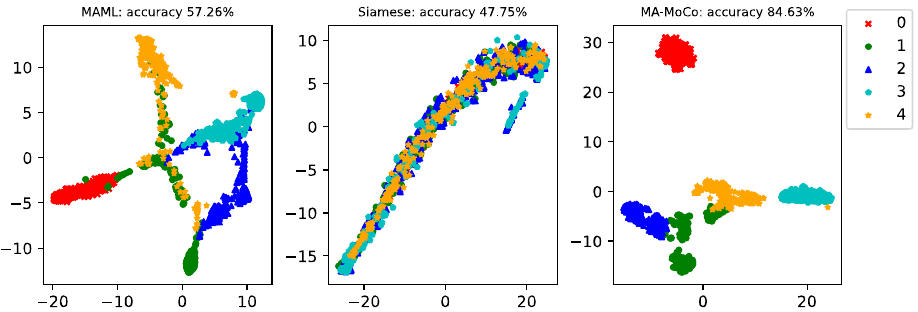
Figure 8. A 5-way 1-shot diagnosis of the generator bearing data when the training set of each class has only 10 fault